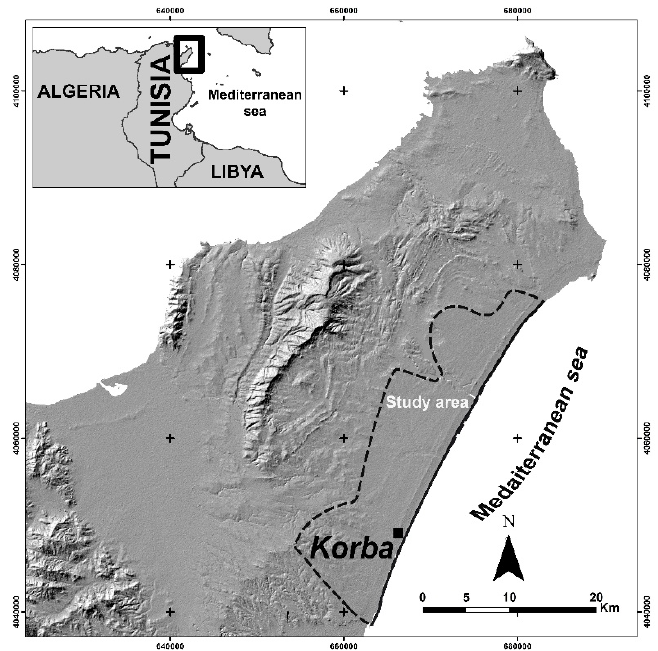
Figure 1. Location map of Tunisia and the Korba region located in the Cap-Bon Peninsula (projection system: TUN UTM; datum: WGS_1984; zone: 32).